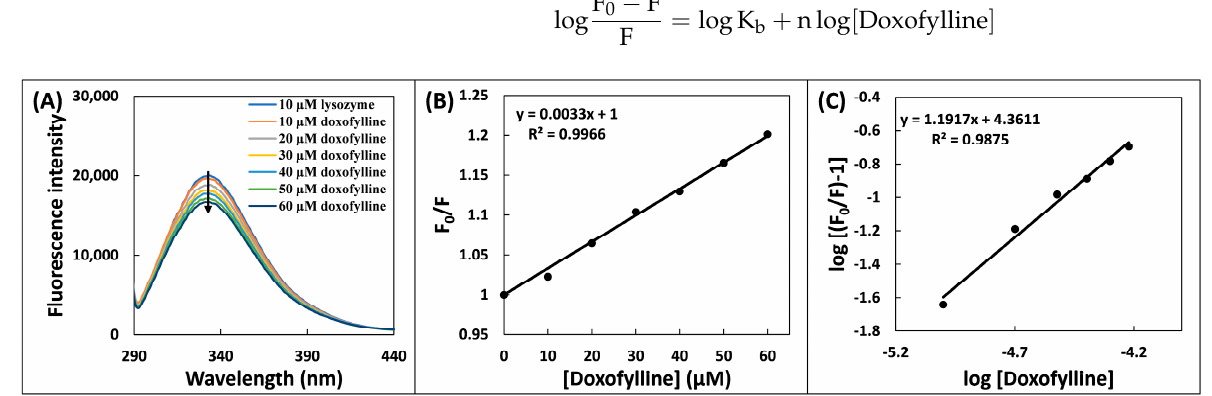
Figure 2. ( A ) Steady state fluorescence spectra of lysozyme (10 µM) in the absence and presence of varying concentrations of doxofylline (0–60 µM). ( B ) Stern–Volmer plot for the lysozyme and doxofylline interaction. ( C ) Double log plot for the lysozyme–doxofylline interaction.